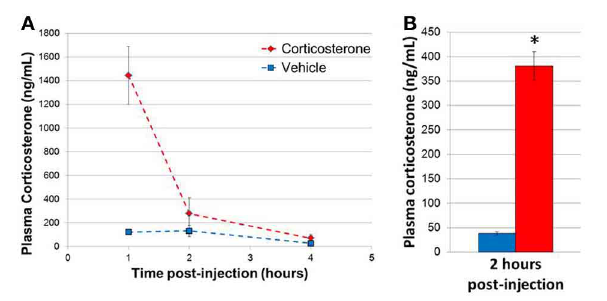
FIGURE 2 | Single injection of 10mg/kg corticosterone results in transient rise in plasma corticosterone levels in mice. (A) Time course of plasma corticosterone levels following injection ( n = 3/treatment/time point). (B) Plasma corticosterone levels in mice (2h post-injection exposure) used in qPCR experiments ( n = 8/group). Error bars = SEM. ∗ p < 0 . 05.